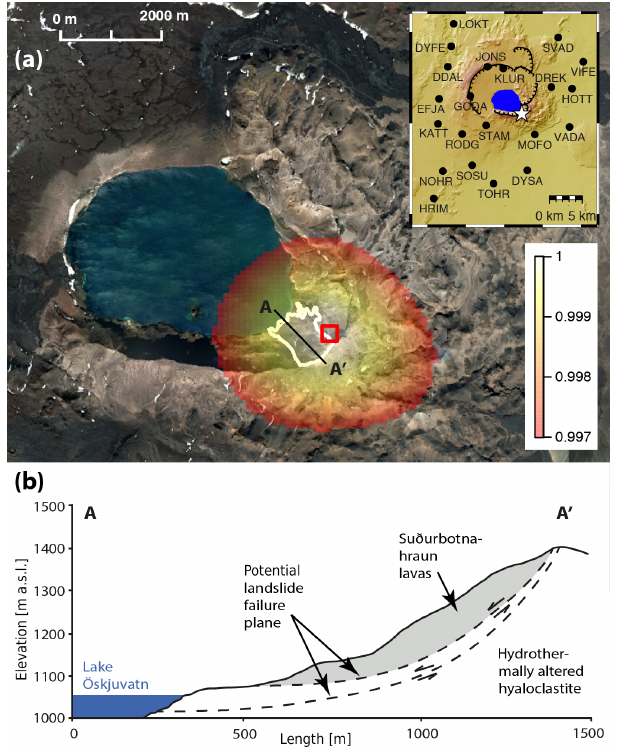
Figure 7. (a) Example of the tremor localisation results using the tremor record of the stations shown in the inset between 23:00:00 and 23:01:00UTC, filtered between 1.5 and 3Hz and a seismic wave velocity of 2300ms − 1 . The open red square is the best-fit location and the ellipse around it is the likelihood quantile from 0.997 (red) to 1 (translucent white). The white line is the outline of the landslide source area. The inset shows the locations of the seis- mic stations used in the localisation and the location of the landslide source area (white star). (b) Hypothetical cross section of the land- slide showing the potential stick-slip tremor